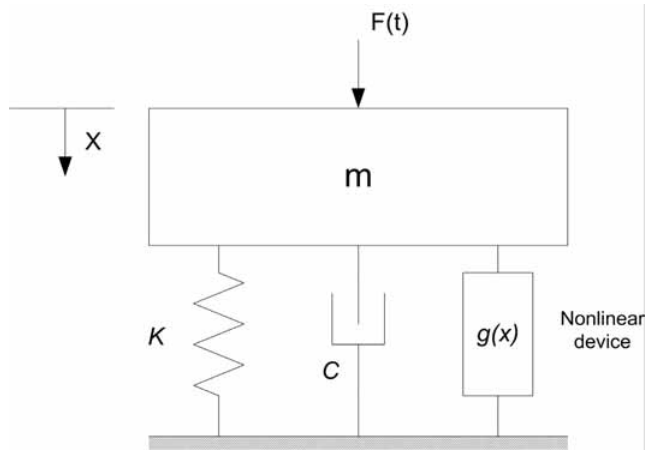
Fig. 3. One degree of freedom mechanical system with a nonlinear